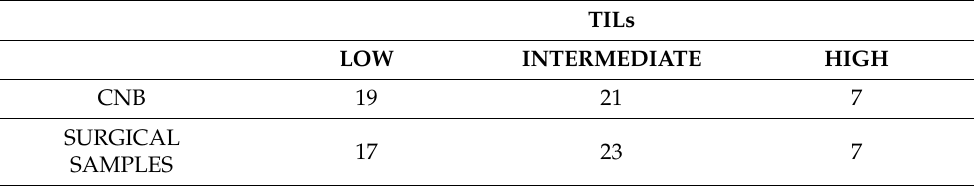
Table 6. TILs distribution in CNB vs. surgical